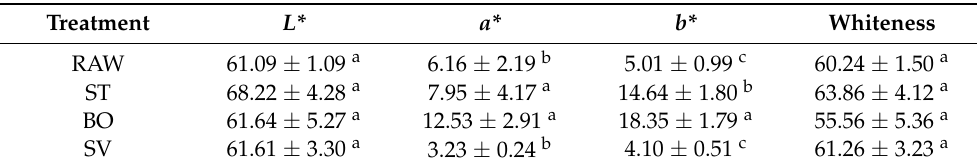
Table 2. L* , a* , b* and whiteness values of squid ( Symplectoteuthis oualaniensis ) mantle muscle samples at different cooking methods.